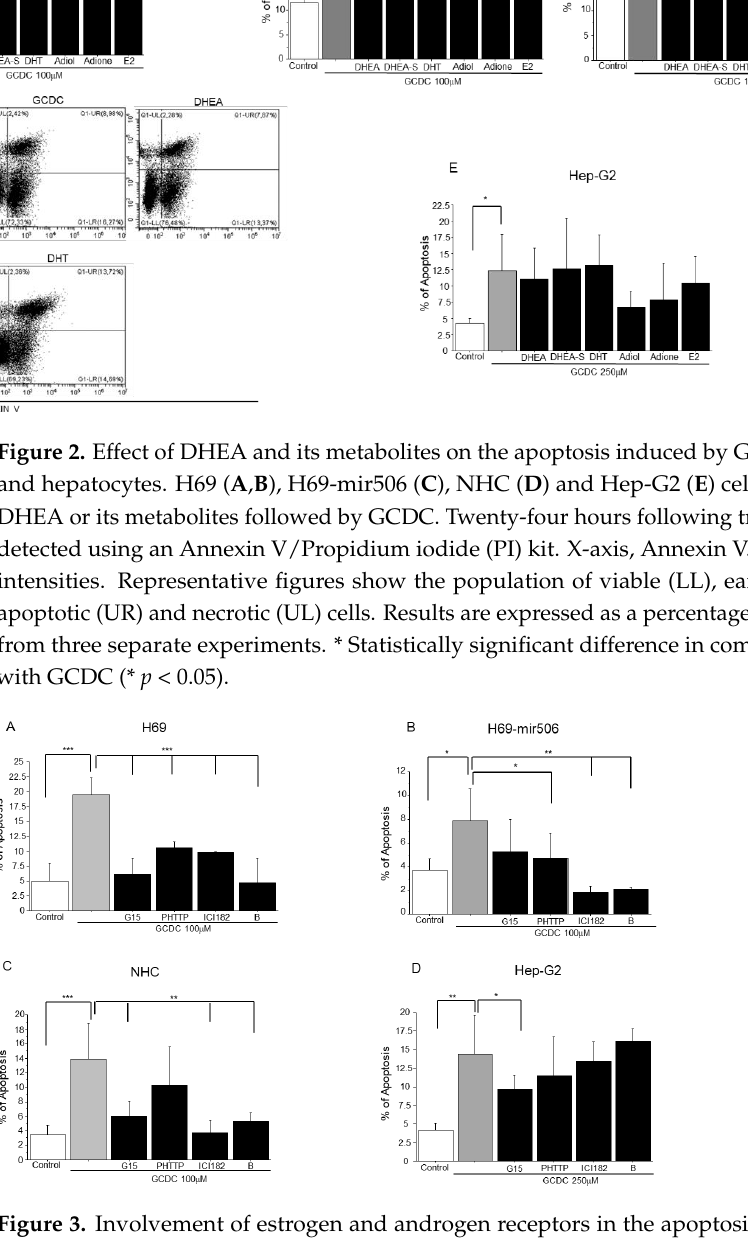
Figure 3. Involvement of estrogen and androgen receptors in the apoptosis induced by GCDC in cholangiocytes (H69, H69-miR506, NHC) and hepatocytes (Hep-G2). Cells ( A – D ) were incubated with estrogen (GPER, ER- α , and ER- β ) or androgen receptor inhibitors i.e., G15 (12 nM); ICI 182,780 (2 nM); PHTTP (10 nM), and bicalutamide ( B ) (10 nM), followed by GCDC treatment. After 24 h, cells were harvested by scraping and then incubated with Annexin V-FITC (1 ng/mL) and propidium iodide (5 ng/mL) for 30 min in the dark. They were analyzed by CytoFLEX LX flow cytometry, * p < 0.05; ** p < 0.01, *** p <